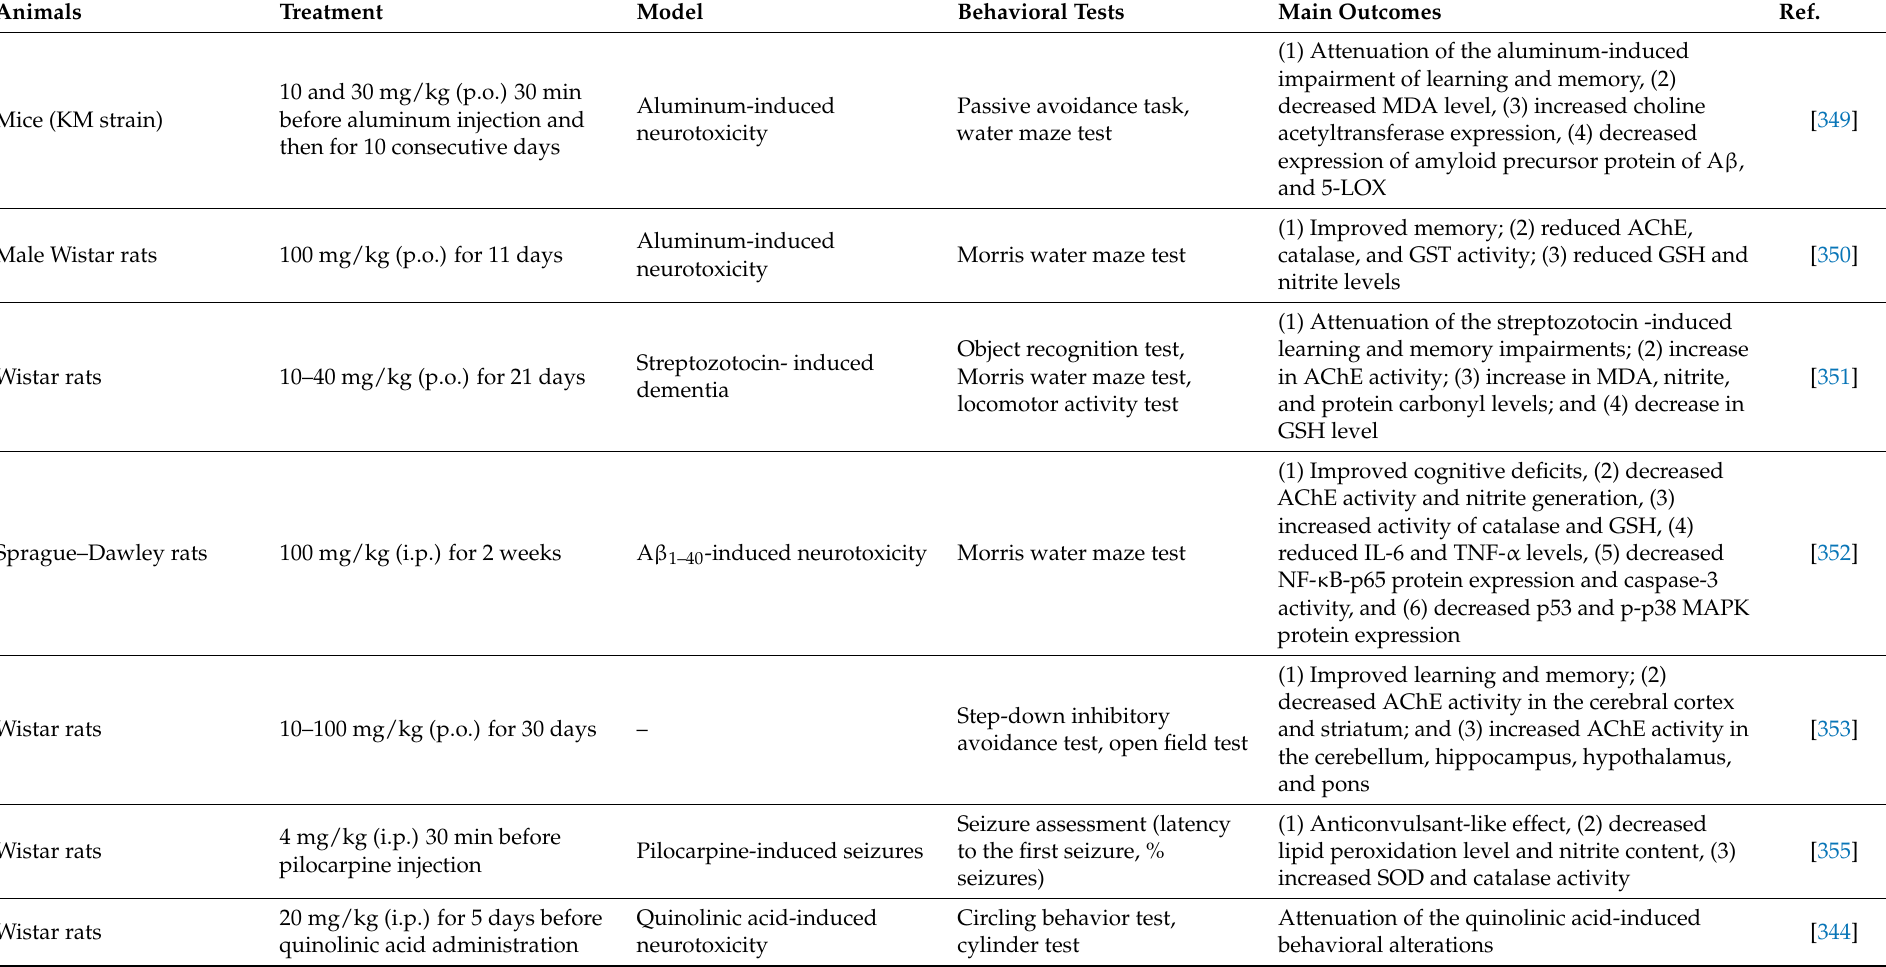
Table 5. Summary of in vivo studies on the neuroprotective effects of caffeic